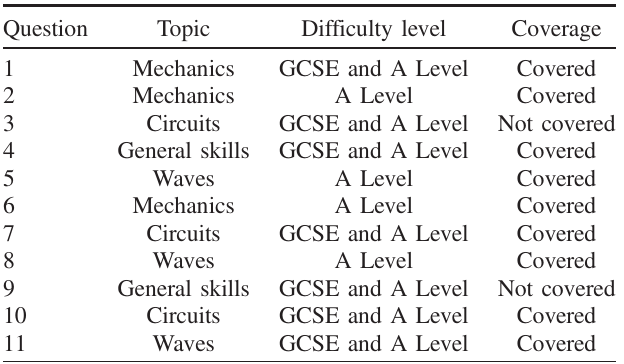
TABLE IV. Cronbach ’ s alpha for all of the 23 statements combined and for the 2 different topics during the Bootcamp.